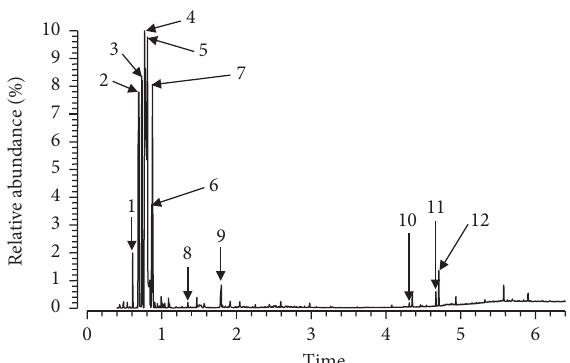
Figure 3: Total ion chromatograms of extracts of textile effluent B from the studied site. Peak numbers correspond to the chemical compounds indicated in Table 3.